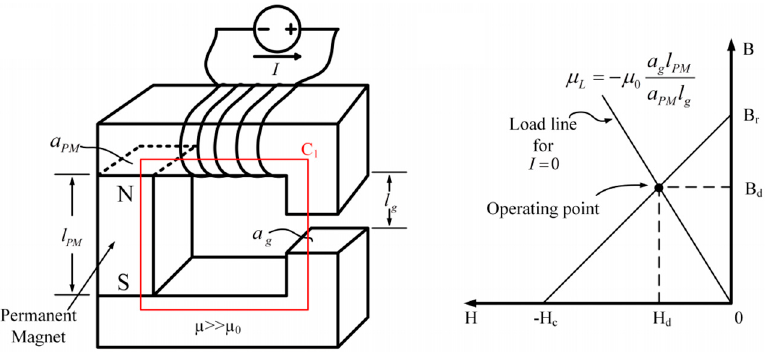
Figure 1. Three operating points for three different permeance coefficients.